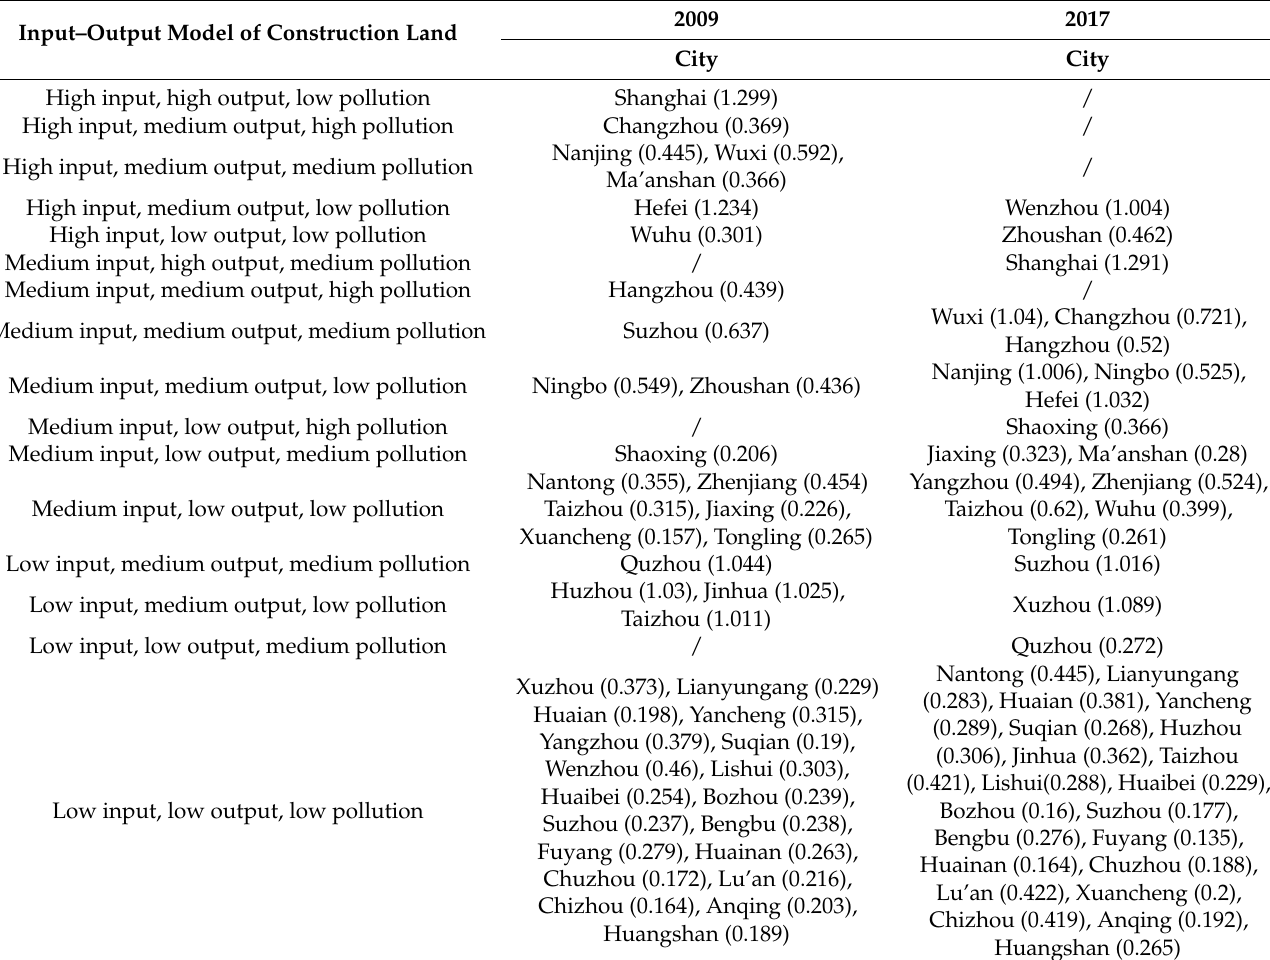
Table 2. Correlation types for input–output and pollution emissions of construction land use in cities of the Yangtze River